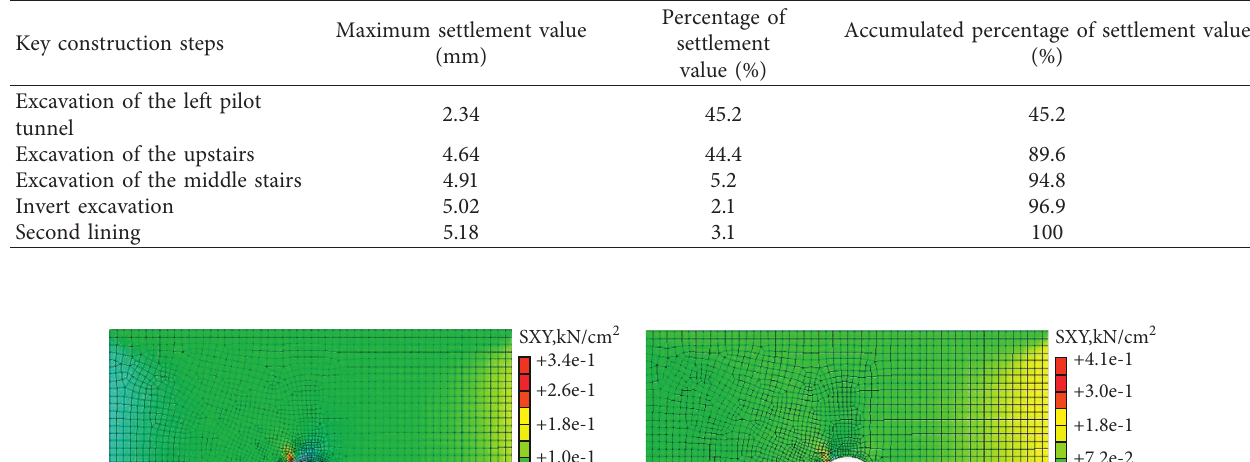
Table 2: Maximum settlement value of each key construction sequence.